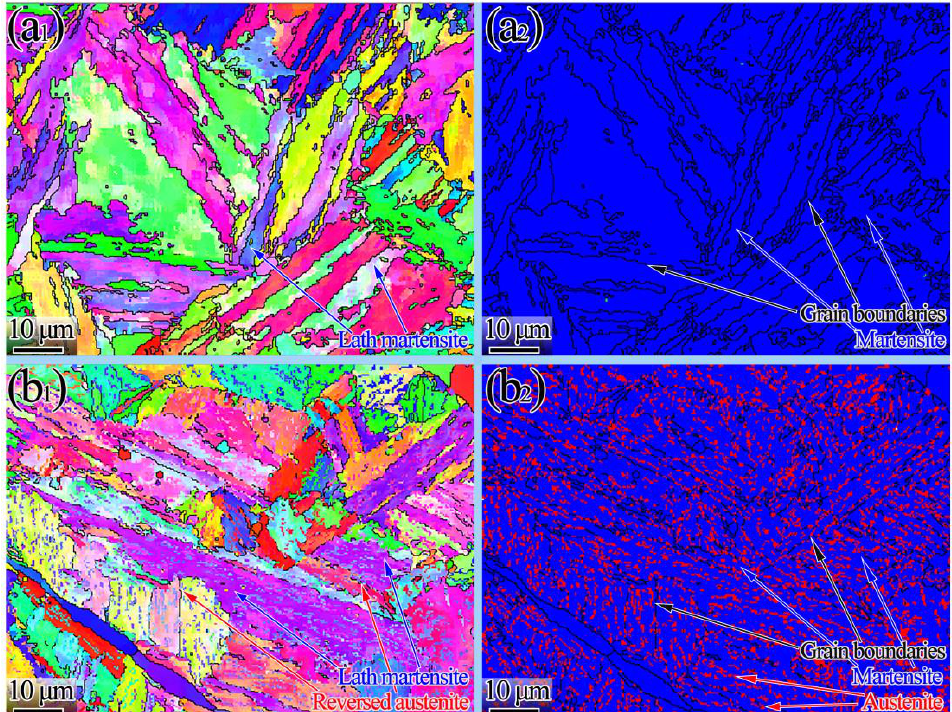
Figure 3. IPF (the high-angle grain boundary marked by black lines (>15°) (the first column) and phase maps (martensite in blue, austenite in red, and black boundaries correspond to misorientation higher than 15°) (the second column)): ( a 1 , a 2 ) 675 °C (3 h); ( b 1 , b 2 ) 675 °C (3 h) + 600 °C (2 h).